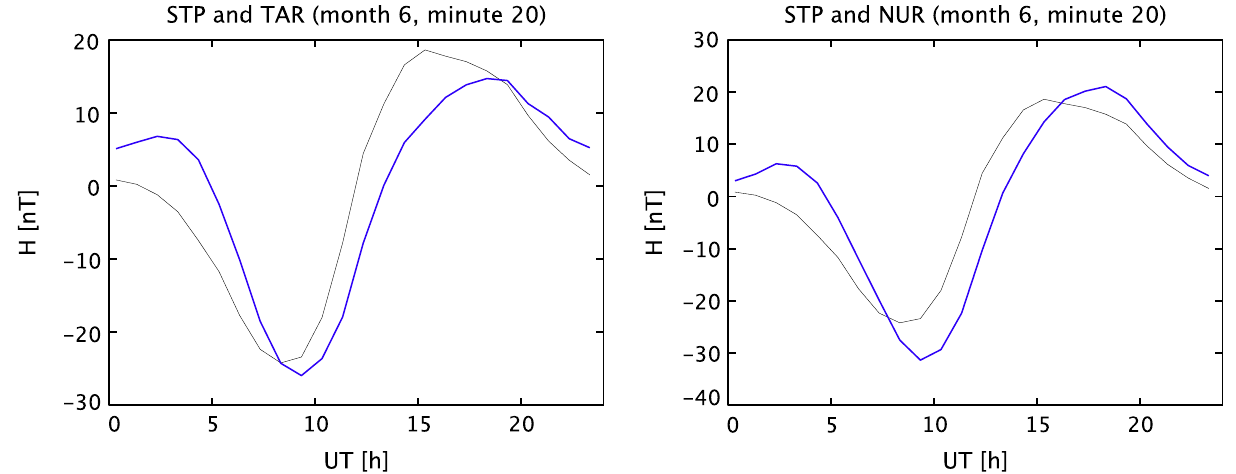
Fig. 5. Average diurnal variation of the magnetic north component ( H ) at TAR and STP (left) and at NUR and STP (right). Black curves correspond to STP and blue curves to NUR and TAR. Results for the eastward component ( E ), not plotted here, show an equally good similarity. We assumed that the declination at NUR and TAR is 5.5 (cid:3) (positive eastwards) when determining the magnetic north and east components from the geographic components ( X , Y